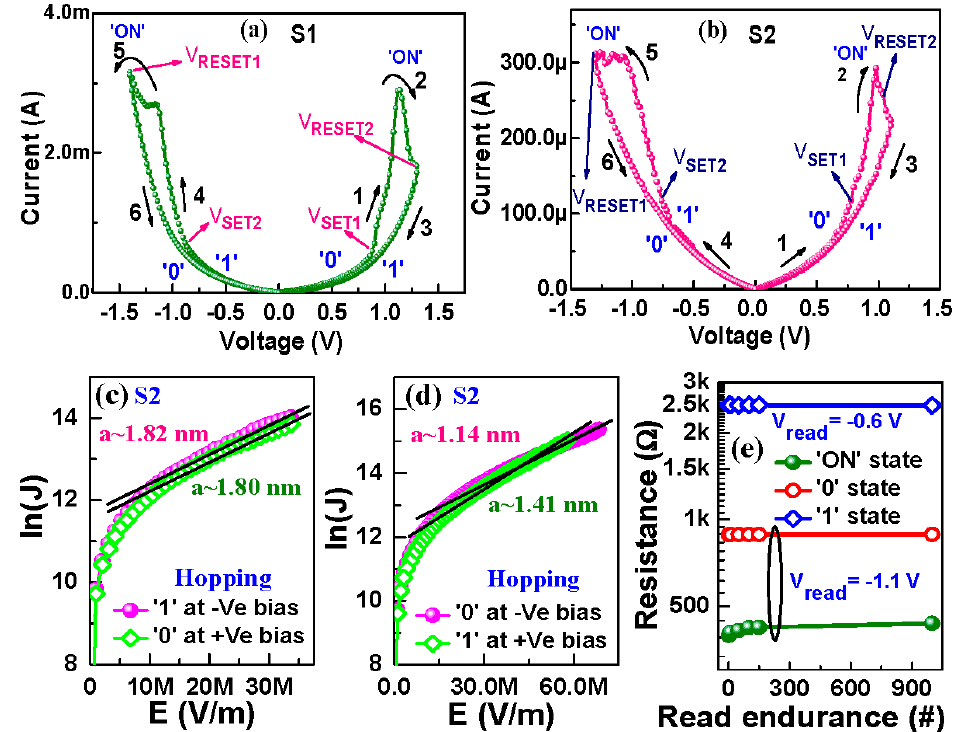
Figure 8. Complementary resistive switching characteristics of the S1 and S2 memristors with a size of 8 × 8 µm 2 . Typical CRS characteristics of the ( a ) S1 and ( b ) S2 memristors. The S2 device shows a low current